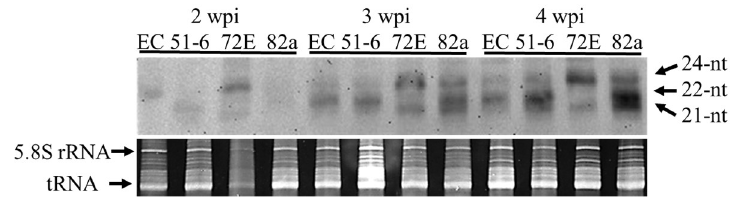
Figure 5. Time course analysis of PSTVd-sRNA accumulating in PSTVd-infected DCL2/4i-transgenic tomato lines. Total RNAs (~10 μg) extracted from three transgenic lines inoculated with PSTVd and line EC at 2, 3, and 4 wpi were separated in 8M-urea 12% PAGE, transferred to nylon membrane, and analyzed by RNA gel-blot hybridization analysis using a DIG-PSTVd-cRNA probe. The upper panel shows the hybridization signal and the lower panel shows the loading control stained with ethidium bromide. All the lines except for 72E showed a dense hybridization signal at the position 22 nt and faint signals at 21 and 24 nt. In contrast, line 72E showed a dense signal at 24 nt and a faint signal at 21 nt. The signal at 22 nt was invisible.